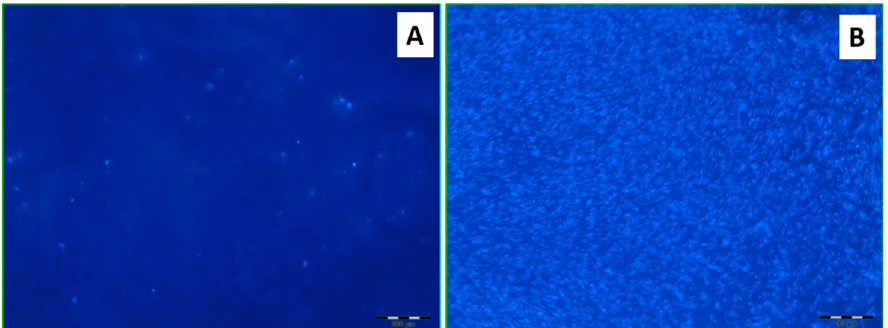
Figure 10. Fluorescent images of DAPI-stained mesenchymal stem cells (MSC) cells on the surface of the initial PLA-based matrix ( A ) and of that modified with RGD-peptide bound to ox-PMAG ( B ). Cell Differentiation (Dynamic Cultivation).